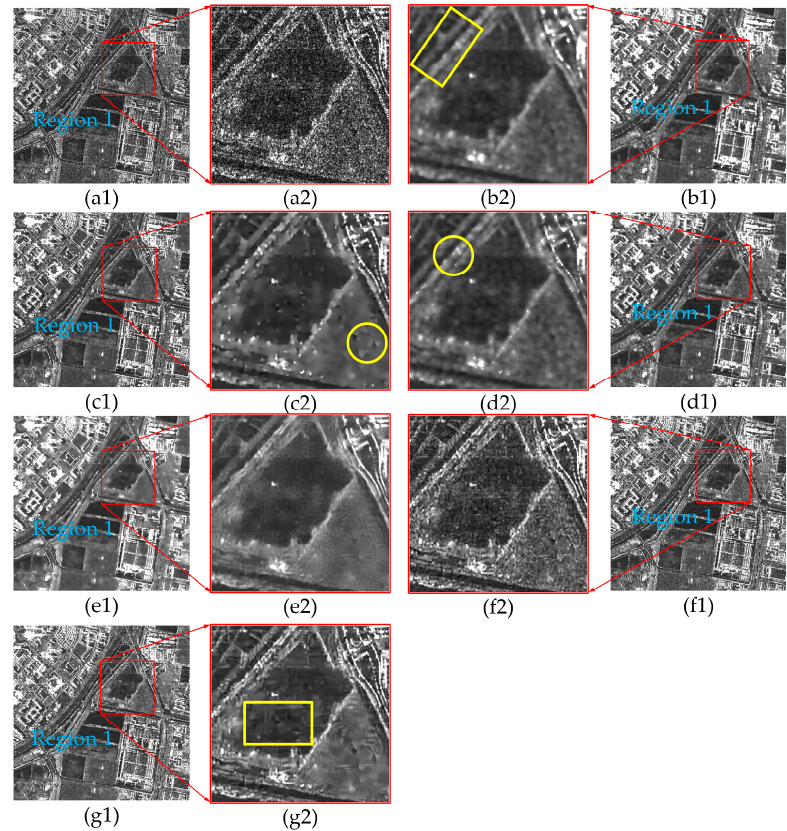
Figure 6. ( a1 ) Noisy TerraSAR-X SAR image. Filtered images by the ( b1 ) SRAD filter, ( c1 ) DPAD filter, ( d1 ) EnLee filter, ( e1 ) PPB filter, ( f1 ) SAR-BM3-D filter, and ( g1 ) FANS filter. ( a2 – g2 ) are the enlarged images of region 1 from ( a1 – g1 ). Table 4. Index evaluation of the TerraSAR-X SAR image.